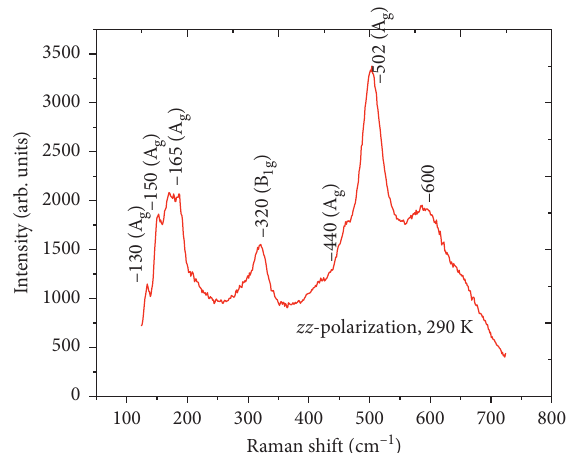
Figure 6: zz polarization Raman spectrum of (110)-oriented Fe doped PBCO thin film.